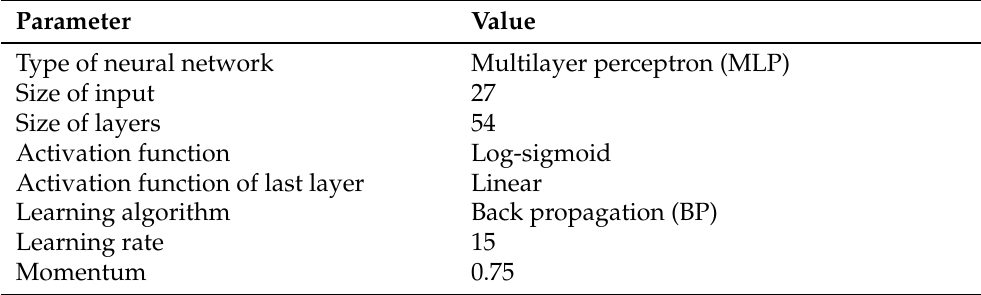
Table 1. MLP network